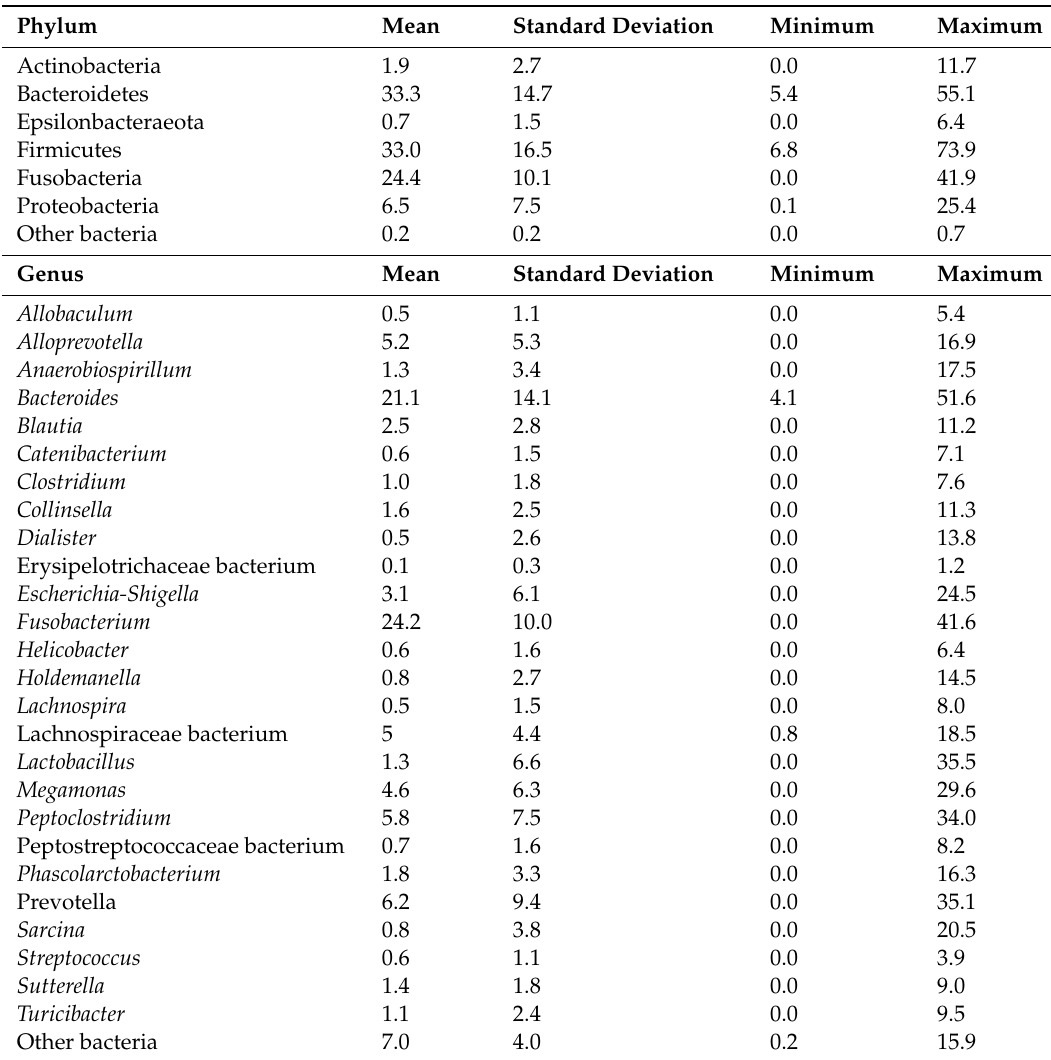
Table 1. Microbial community of companion dogs’ microbiome at the phylum level and genus level in